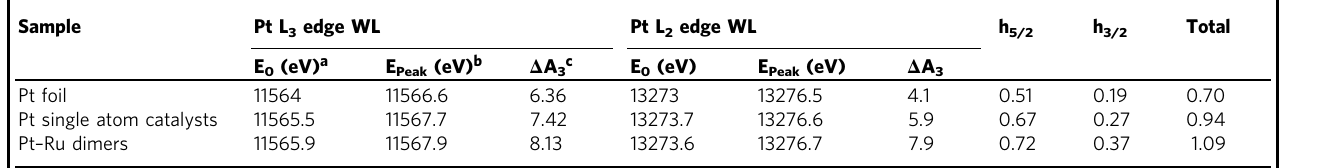
Table 1 Pt L 3,2 -edge threshold and white line (WL) parameters